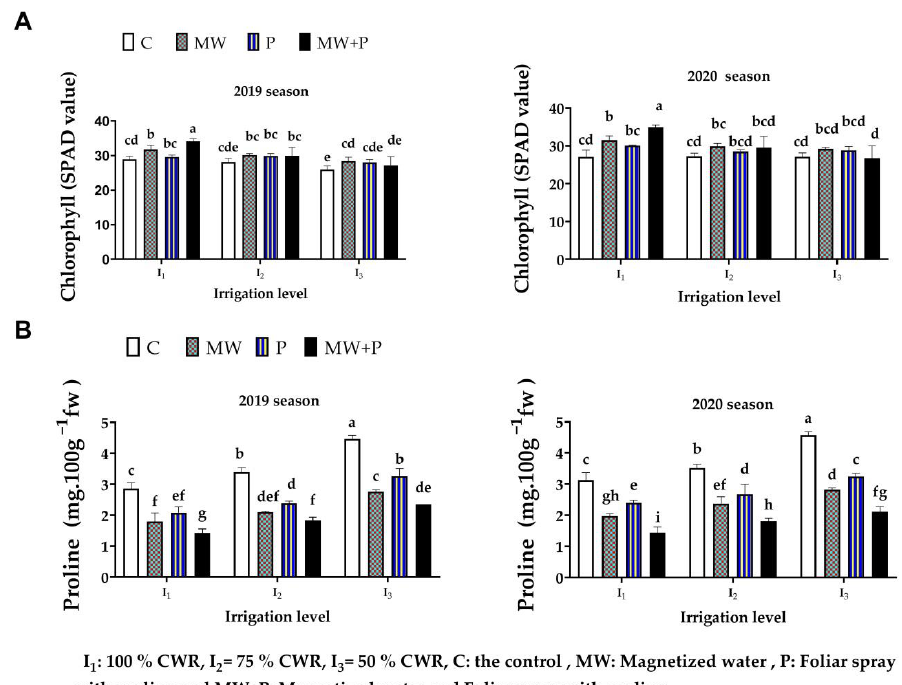
Figure 2. Effect of magnetized water (MW), foliarly sprayed proline (P), and their combination (MW + P) on leaf chlorophyll ( A ) and proline ( B ) contents of “ Taifi ” pomegranate shrubs grown under different irrigation regimes (I 1 , I 2 , and I 3 ), based on cop water requirements (CWR) during the 2019 and 2020 seasons. Values are the means ± standard deviation (SD). Duncan’s multiple range test (DMRT) was used for mean comparisons at p ≤ 0.05 .